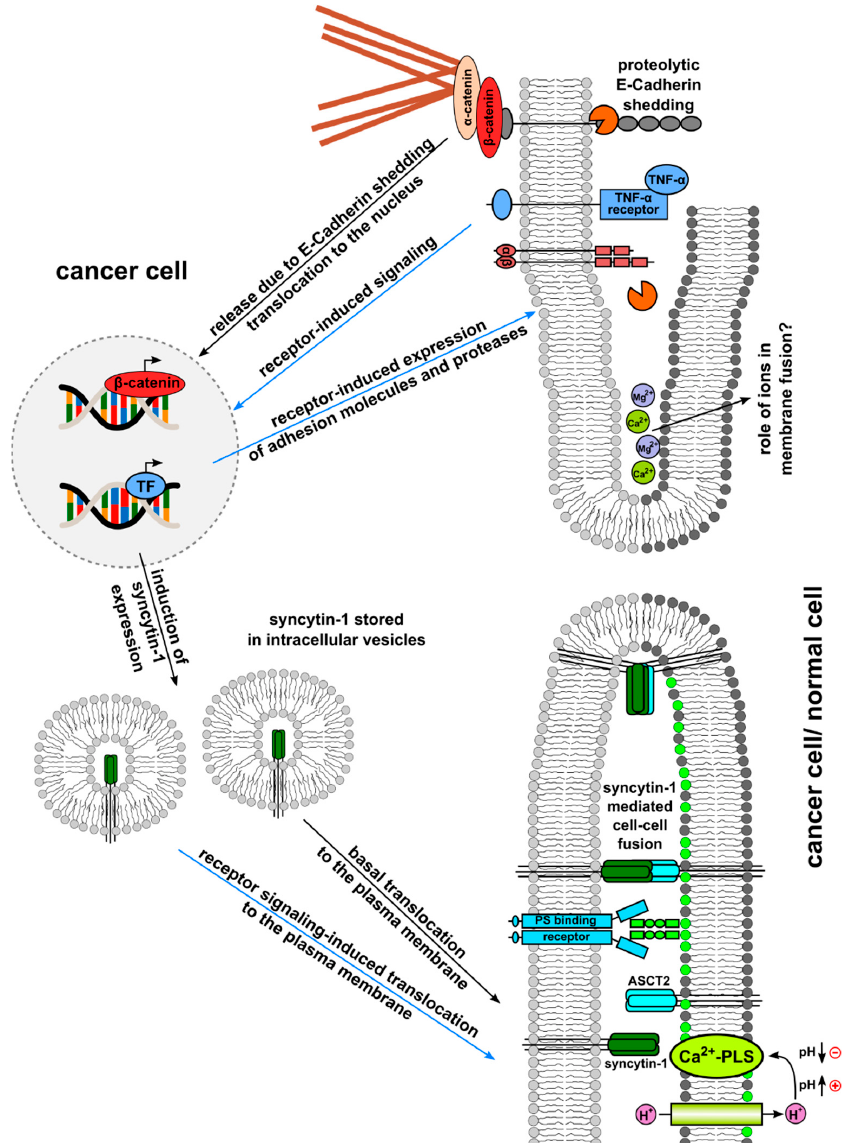
Figure 2. Cancer cell–cell fusion triggered by inflammation/inflammatory cytokines, ions, and pH. In this model based on a previous hypothetic scheme [1], it is assumed that cancer cells basally express syncytin-1 (and/or other fusogens) and a PS-binding receptor, which recognizes ASCT2 and PS, respectively. Fusogens such as syncytin-1 are stored predominantly in intracellular vesicles but could also translocate to the plasma membrane, allowing the cancer cell to enter a potential pro-fusogenic state. TNF- α -receptor-induced signaling could induce both fusogen (syncytin-1) expression and translocation to the plasma membrane. Similarly, TNF- α -receptor-induced signaling could induce expression of adhesion molecules and proteases. Adhesion molecules are mandatory for close cell–cell contact, which is a prerequisite for subsequent cell–cell fusion. Once cells have attached, adhesion molecules and other cell membrane proteins are cleaved by proteases. Proteolytic degradation of E-Cadherin was associated with release of β -catenin from the plasma membrane, nuclear translocation, and transcriptional activation of gene expression. Further extracellular triggers for (cancer) cell–cell fusion are positively charged ions, such as Ca 2+ , Mg 2+ , and H + . While Ca 2+ and Mg 2+ are also required for neutralization of negatively charged plasma membrane phospholipids, TMEM16F activity is modulated by intracellular H + levels/pH